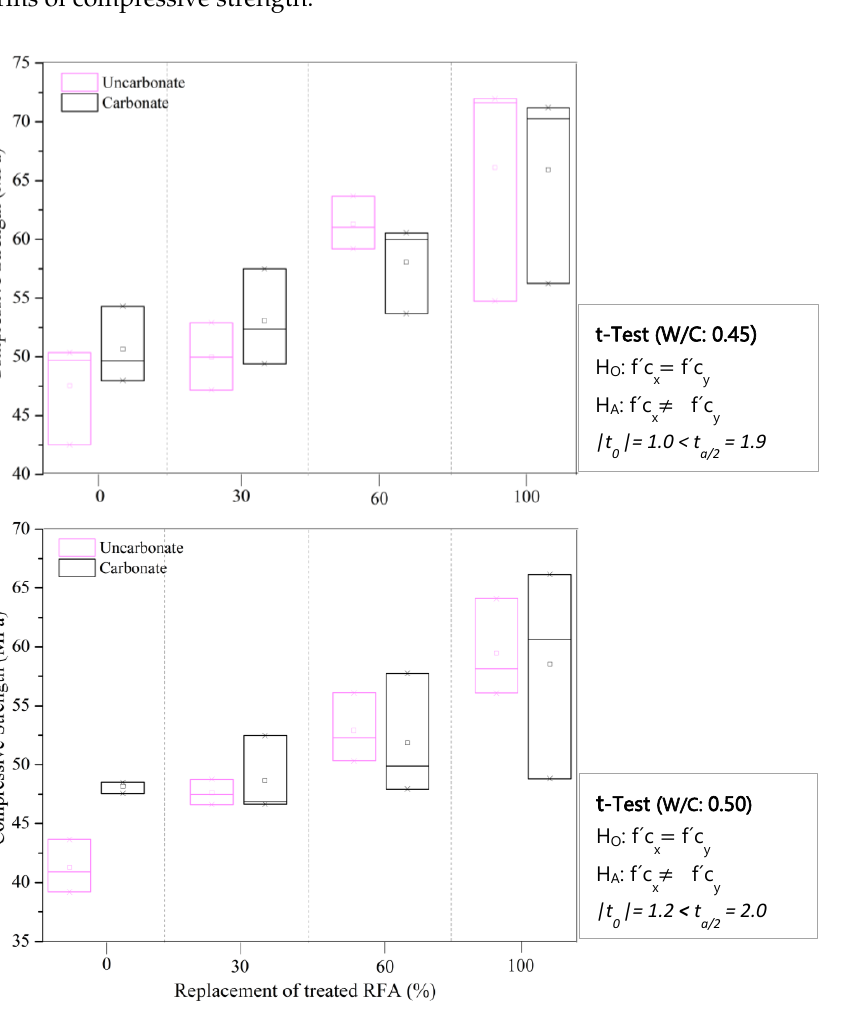
Figure 17. Correlation of 28-day compressive strength with carbonated and uncarbonated mortars with different replacement of treated RFA at 0.5 mol/L – 7d – 20 °C.